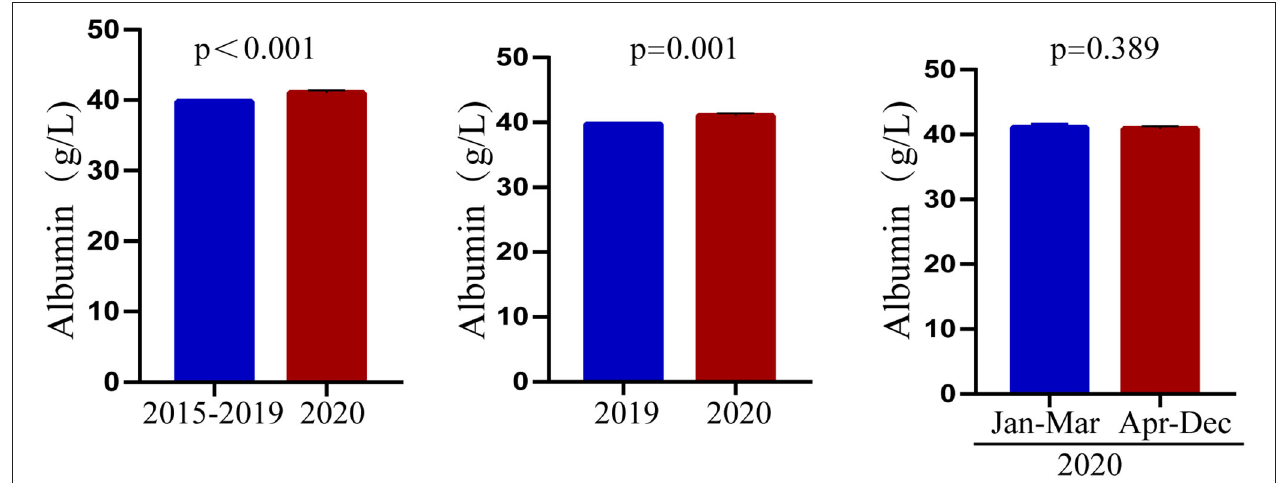
FIGURE 3 | Characteristics of albumin before and after the COVID-19 pandemic.